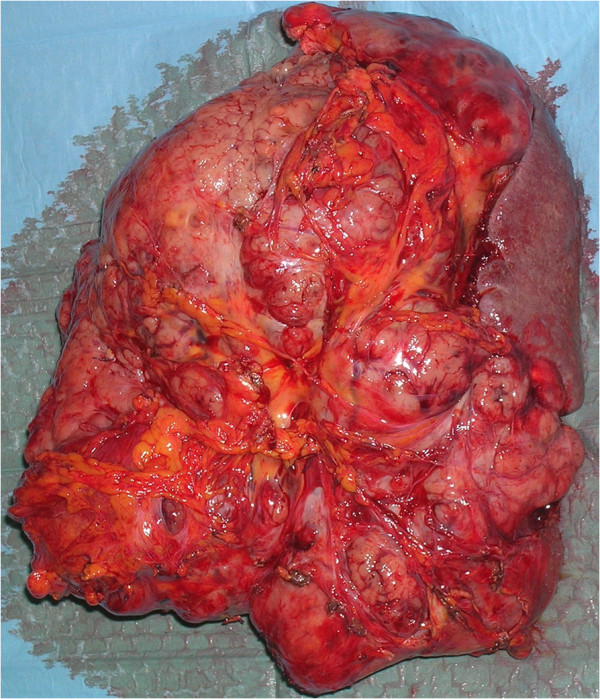
The removed tumor.